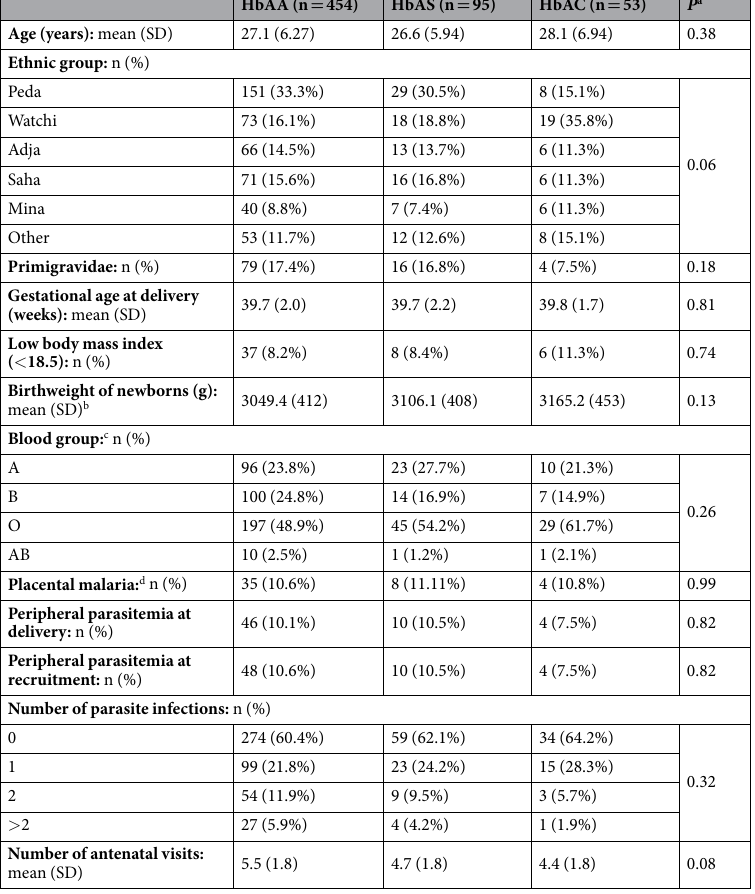
tion at inclusion (p = 0.05) were also associated with a lower mean birthweight.